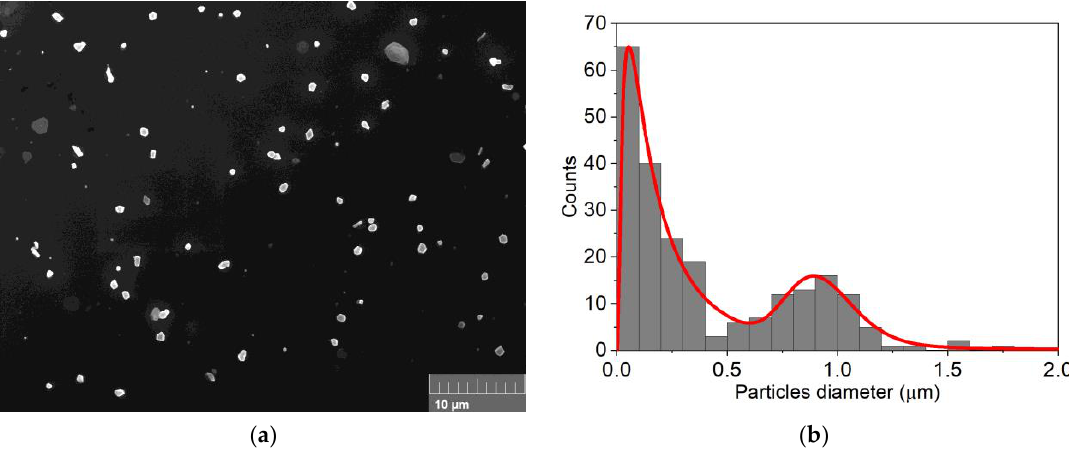
Figure 2. ( a ) SEM analysis of 30 nmol of Cd deposited on n-Si (sample A); ( b ) particles distribution obtained from the SEM image.